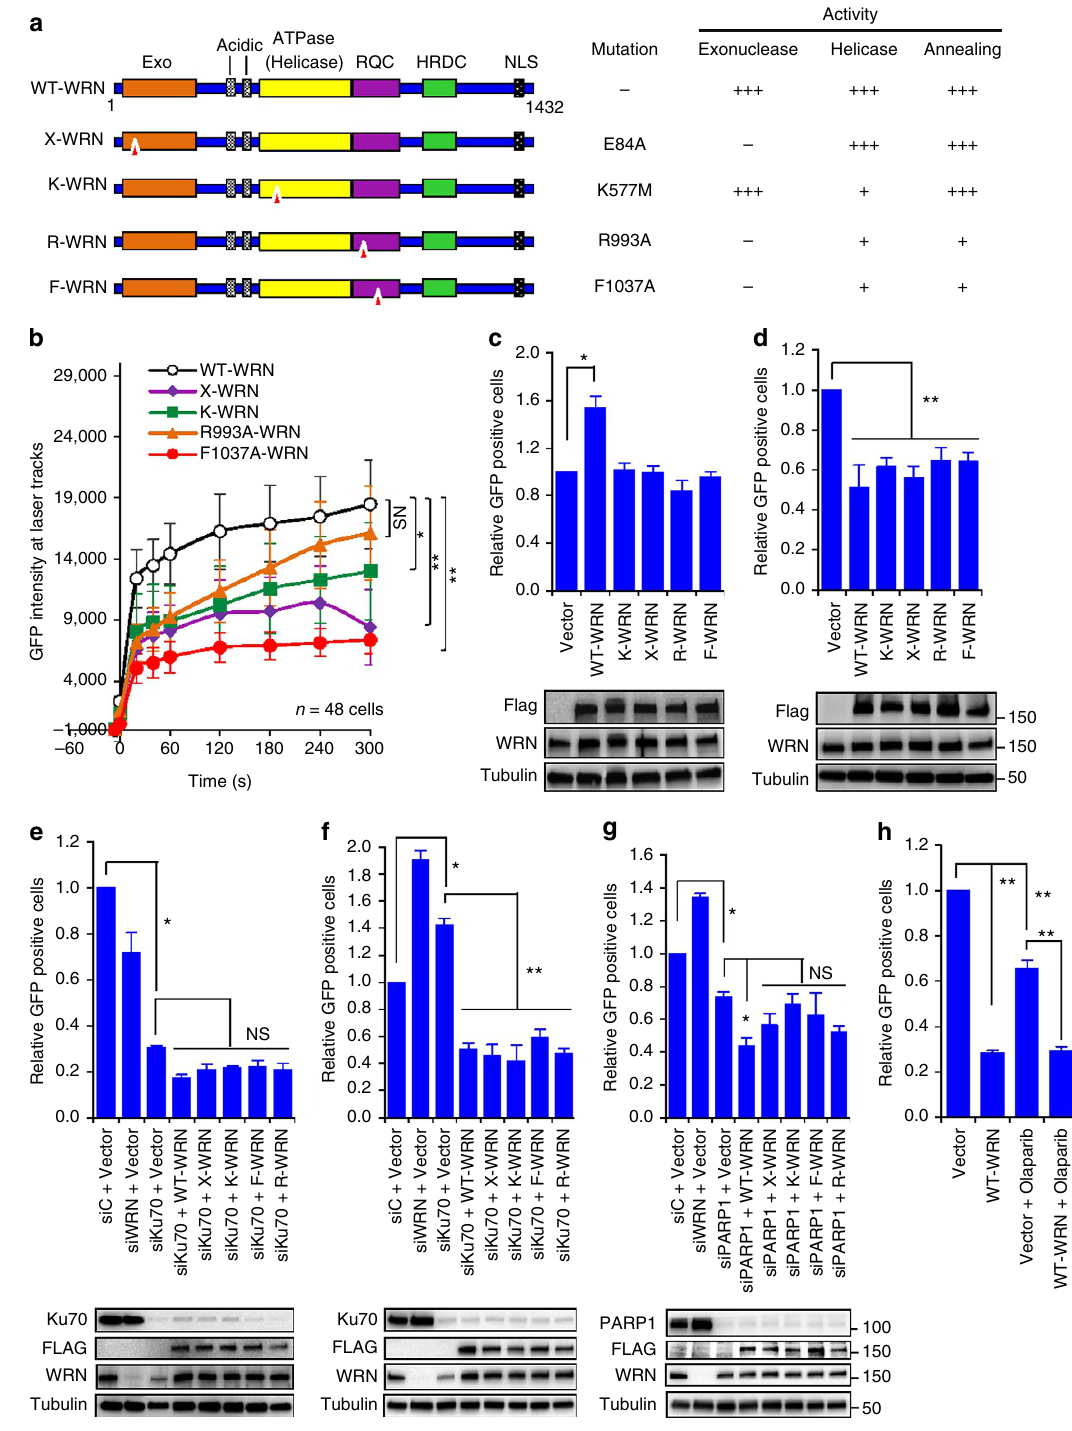
Figure 3 | Enzymatic and non-enzymatic functions of WRN in c-NHEJ and alt-NHEJ. ( a ) Linear structure of WTand WRN mutants along with functional properties. Exo, exonuclease; þ þ þ , high activity; þ , low activity; (cid:2) , no activity. Triangles in red represent mutation position. ( b ) Recruitment kinetics of WTand WRN mutants to DSBs. U2OS cells expressing c-terminal GFP tagged WRN constructs were microirradiated and recruitment of GFP-tagged protein